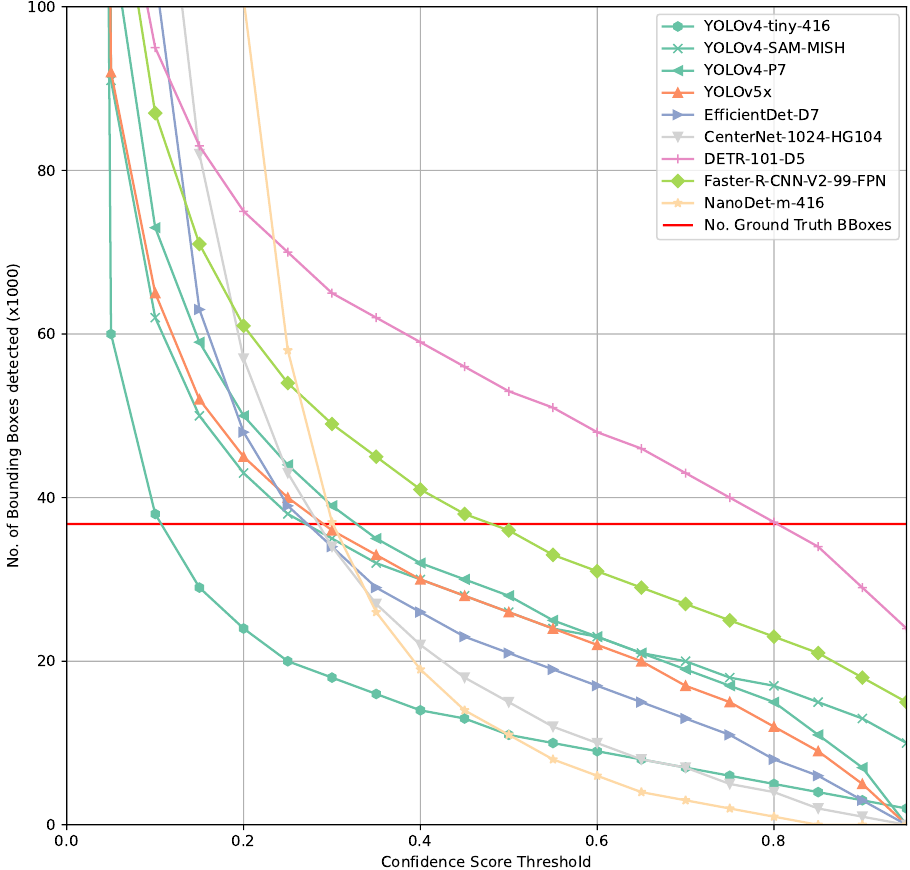
Figure 4. Comparison of number of bounding boxes predicted by selected